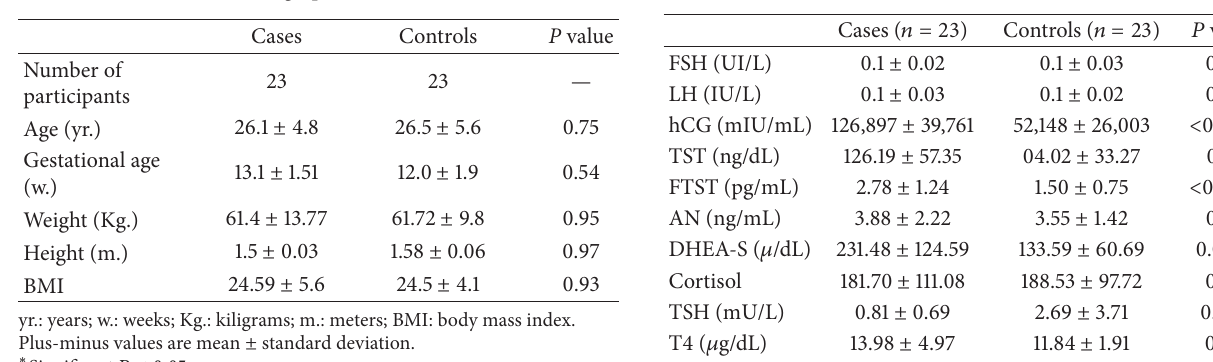
Table 1: Demographic characteristics. Table 2: Cases versus controls before HM